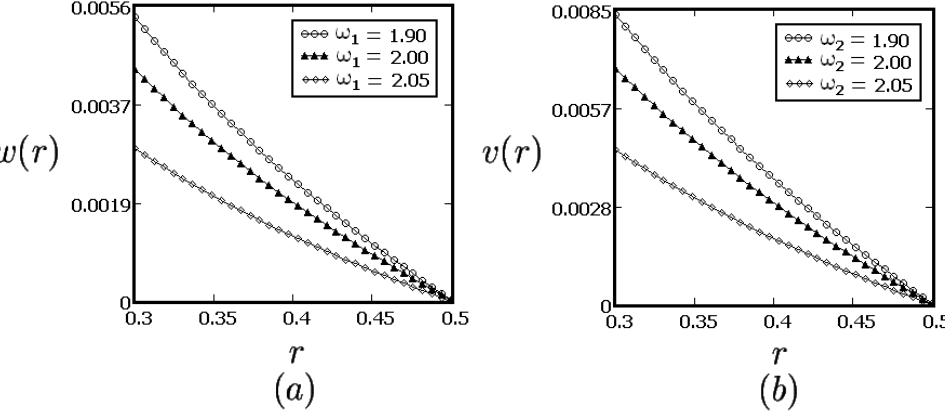
Fig. 8. Profiles of the velocity components w ( r , t ) and v ( r , t ) given by Eqs. (39), for R 1 = 0.3, R 2 = 0.5, f = g = −2, ν = 0.1188, µ = 10.384, α = 0.2, t = 8 s and different values of ω 1 and ω 2 .